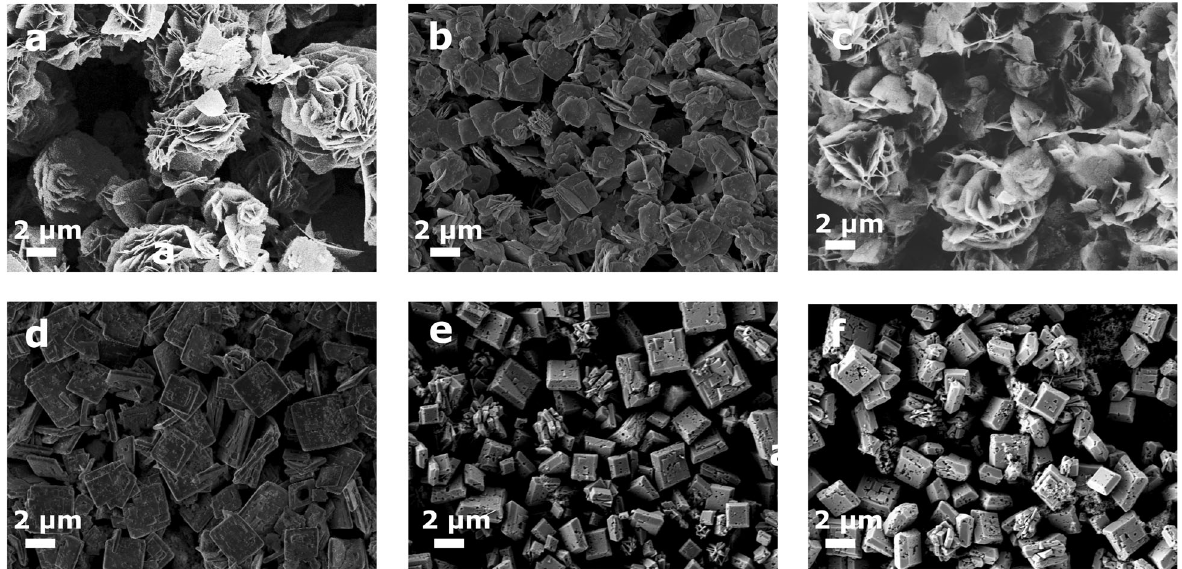
Fig. 2 SEM micrographs of layered SnO particles produced in various re fl uxing alcohols. a ethanol, b 1-propanol, c 2-propanol, d 1-butanol, e 1-pentanol and f